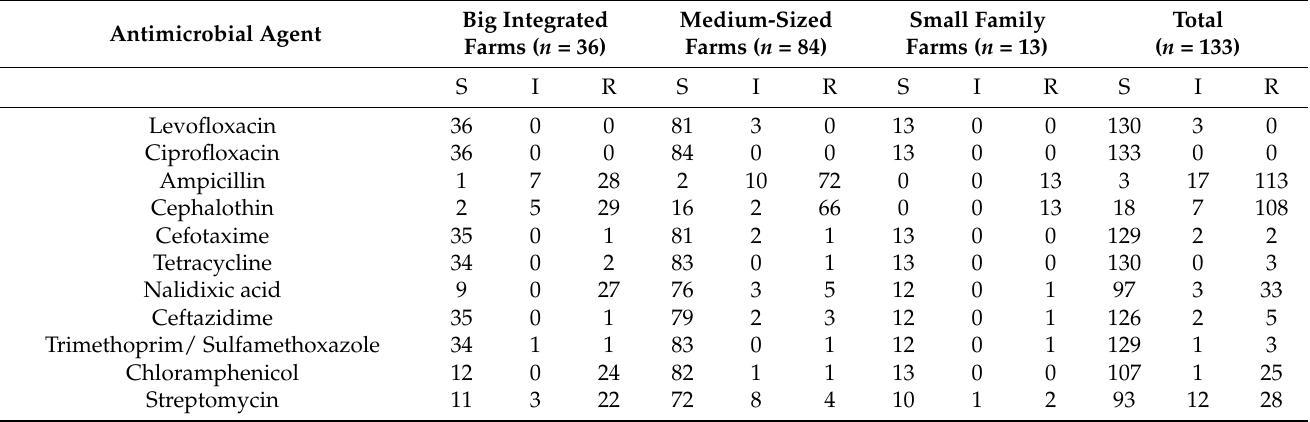
Table 7. Antimicrobial susceptibility of Y. enterocolitica 4/O:3 isolates collected in two surveys of tonsils from pigs raised in different housing systems.